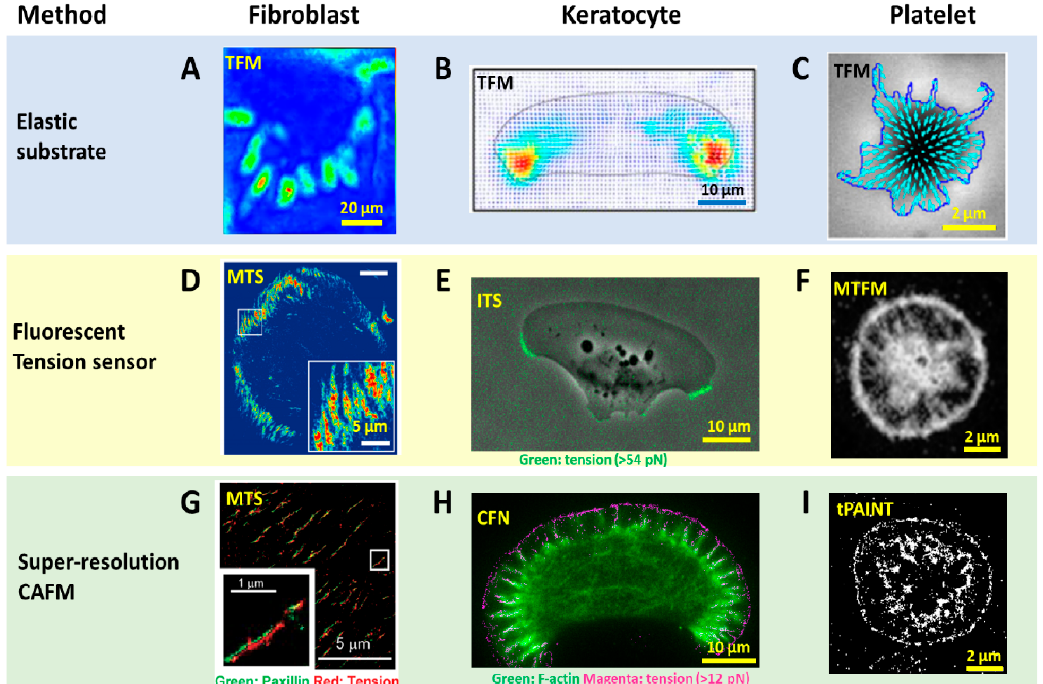
Figure 2. Advances in spatial resolution of cell adhesive force imaging techniques. ( A – C ) Force maps of a fibroblast [57], a migatory keratocyte [58] and a stationary platelet [59] obtained by TFM. The resolution is in the range of 1–5 µ m. ( D – F ) Force maps of a fibroblast obtained by molecular tension sensor (MTS) [43], a keratocyte obtained by integrative tension sensor (ITS) [50] and a platelet obtained by molecular tension fluorescence microscopy (MTFM) [60], respectively. The resolutions are at the di ff raction limit: 0.3–0.4 µ m. ( G – I ) super-resolution force maps of a fibroblast obtained by MTS assisted with Bayesian computation [61], a keratocyte obtained by cellular force nanoscopy (CFN) [54] and a platelet obtained by tPAINT [55], respectively. Resolutions were reported as 50–100 nm for the live cell samples.